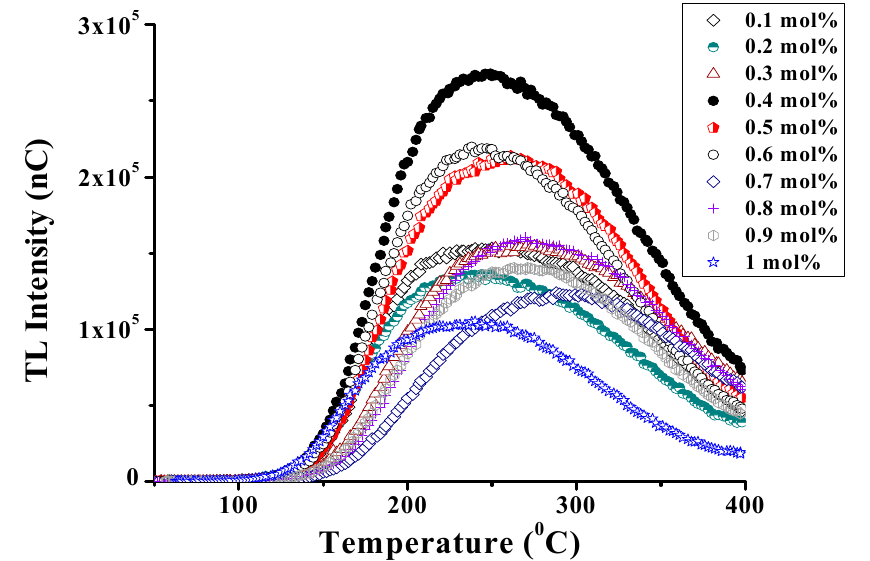
Figure 5. Heating rate dependence of thermoluminescence (TL) from MgB 4 O 7 :Zn glass.